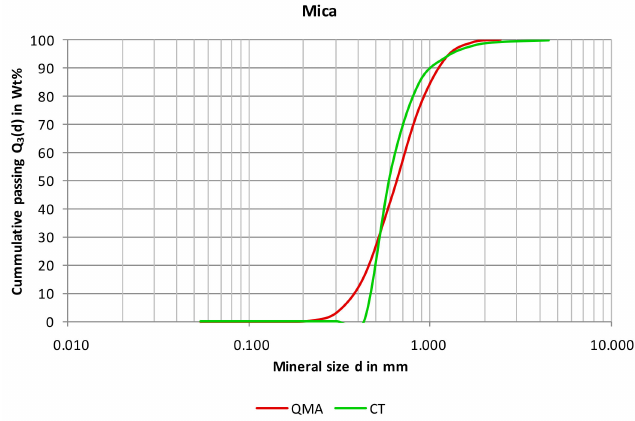
Figure 17. Grain size distributions of mica in granodiorite.